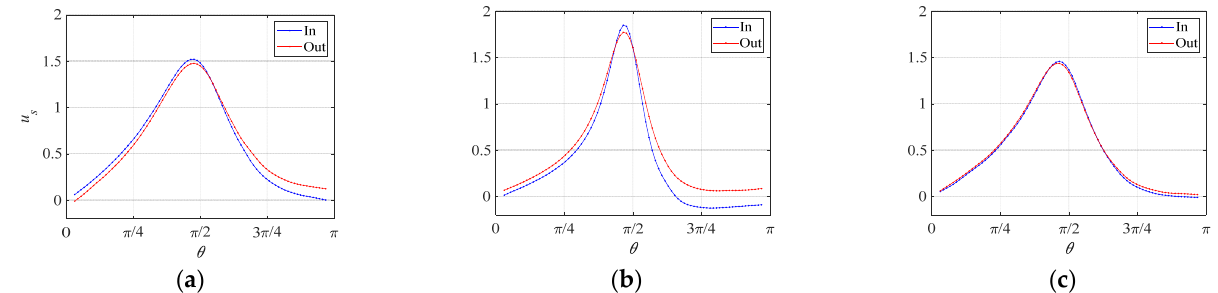
Figure 8. Velocity at bubble surface: ( a – c ) are under same conditions as those in Figure 7. ( a ) S = 4; ( b ) S = 4; ( c ) steady. Velocity inside gap in equatorial plane is larger. However, rear velocity inside gap is smaller.